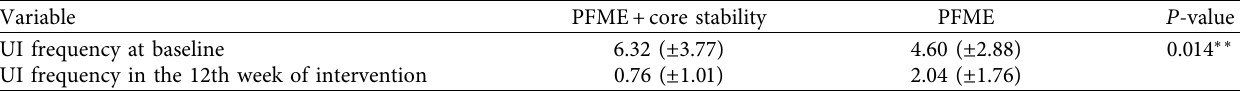
Table 4: Incontinence severity index after the 12th week of